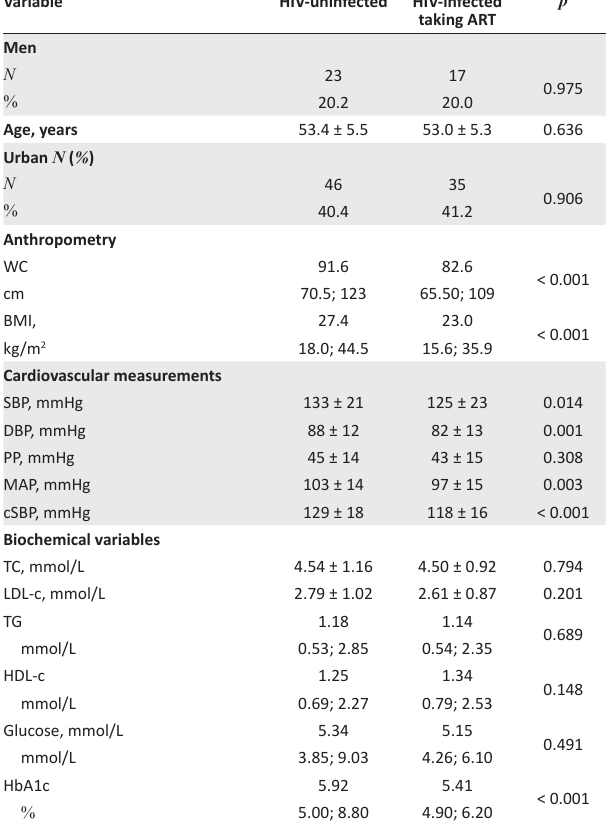
TABLE 2-A1 (Continues...): Characteristics of the HIV-uninfected and HIV-infected individuals taking antiretroviral therapy.